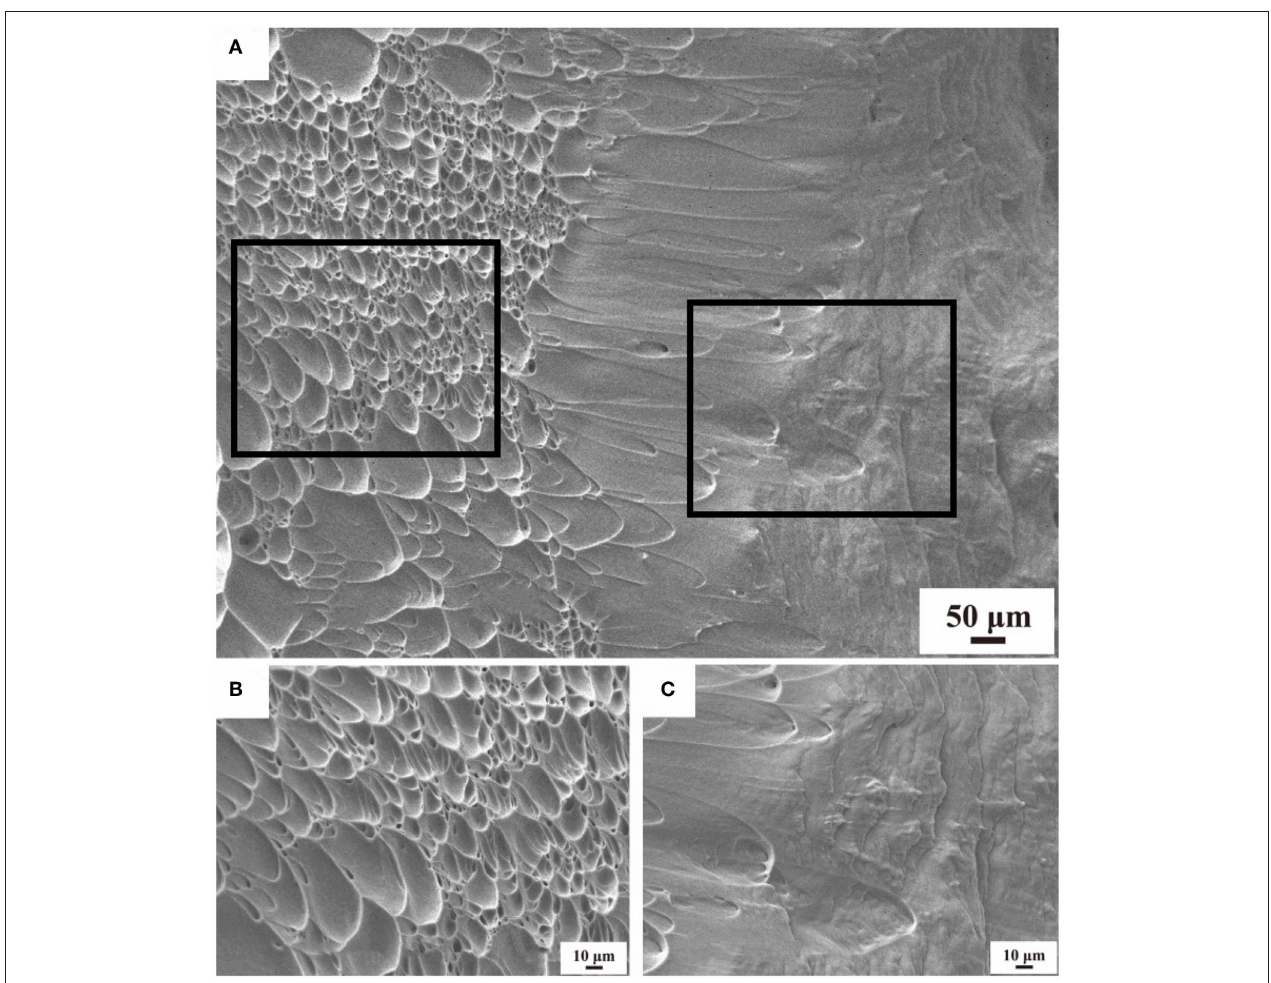
FIGURE 7 | The SEM fractographic images: (A) the laser-quenched Ti-35Nb-2Ta-3Zr alloy, (B,C) show high-magnification images taken from the black rectangle in (A) .